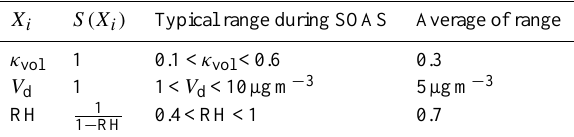
Table 3. Table of sensitivity ratios S (X i ) based on Eq. (1) for X i equal to κ vol , V d , and RH. The table also reports the typical range of these parameters during the SOAS campaign. X i Typical range during